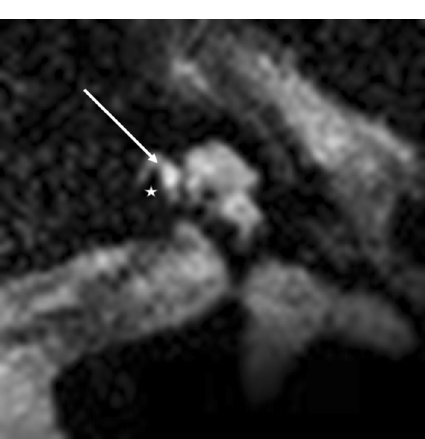
Figure 3. Modiolar electrode, basal turn, HFMS. Star represents diminishing electrode signal, arrow represents basilar